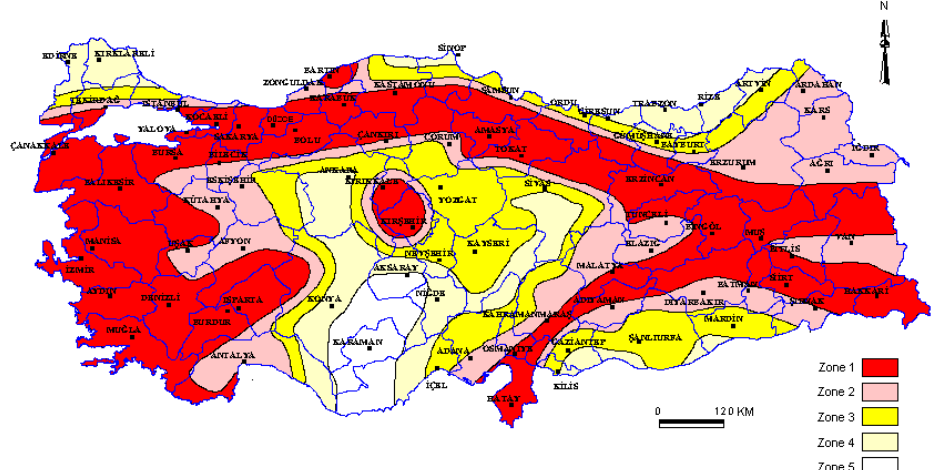
Fig. 1. Simplified tectonic map of Turkey (modified from USGS, 2008).